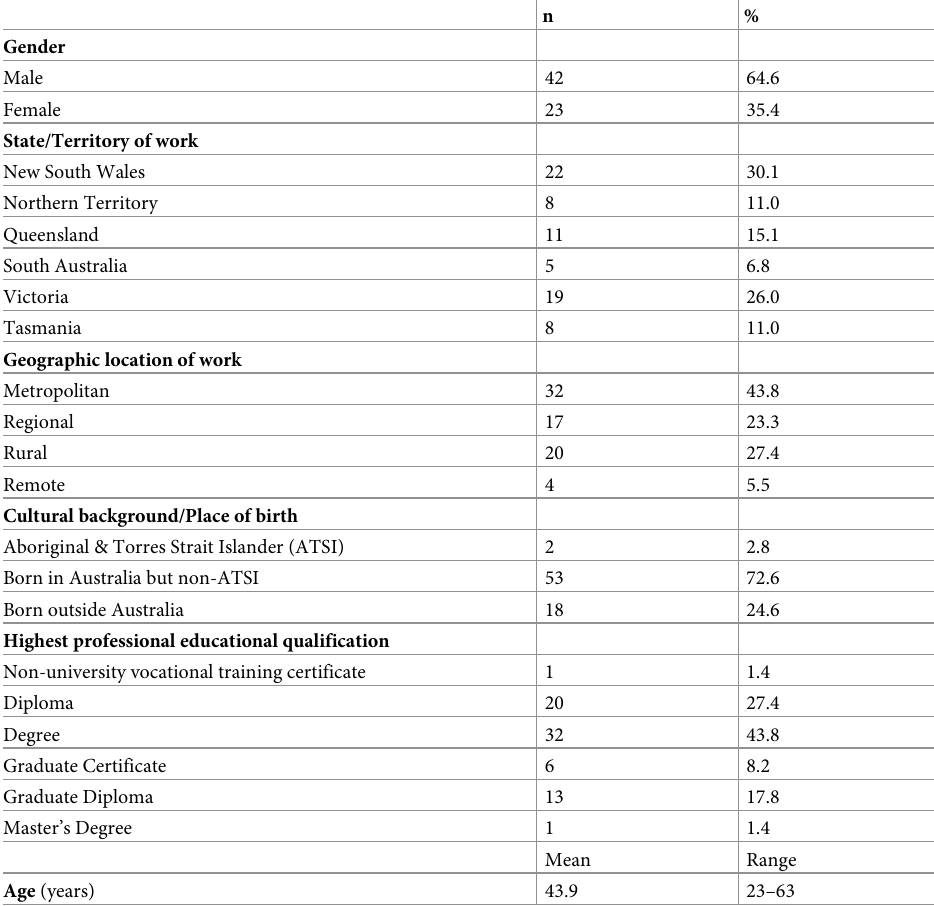
Table 1. Paramedic participants’ sociodemographic and workplace details (N =